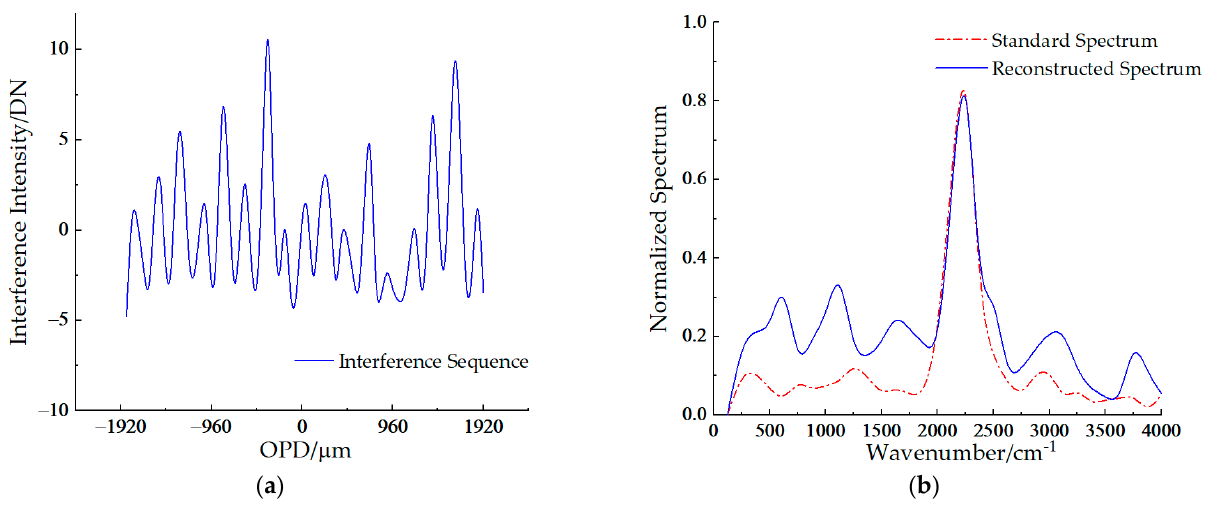
Figure 14. The reconstructed spectrum of the letter “C” during the physical simulation: ( a ) the interference sequence of the ( x , y ); ( b ) the reconstructed spectrum and the standard spectrum.